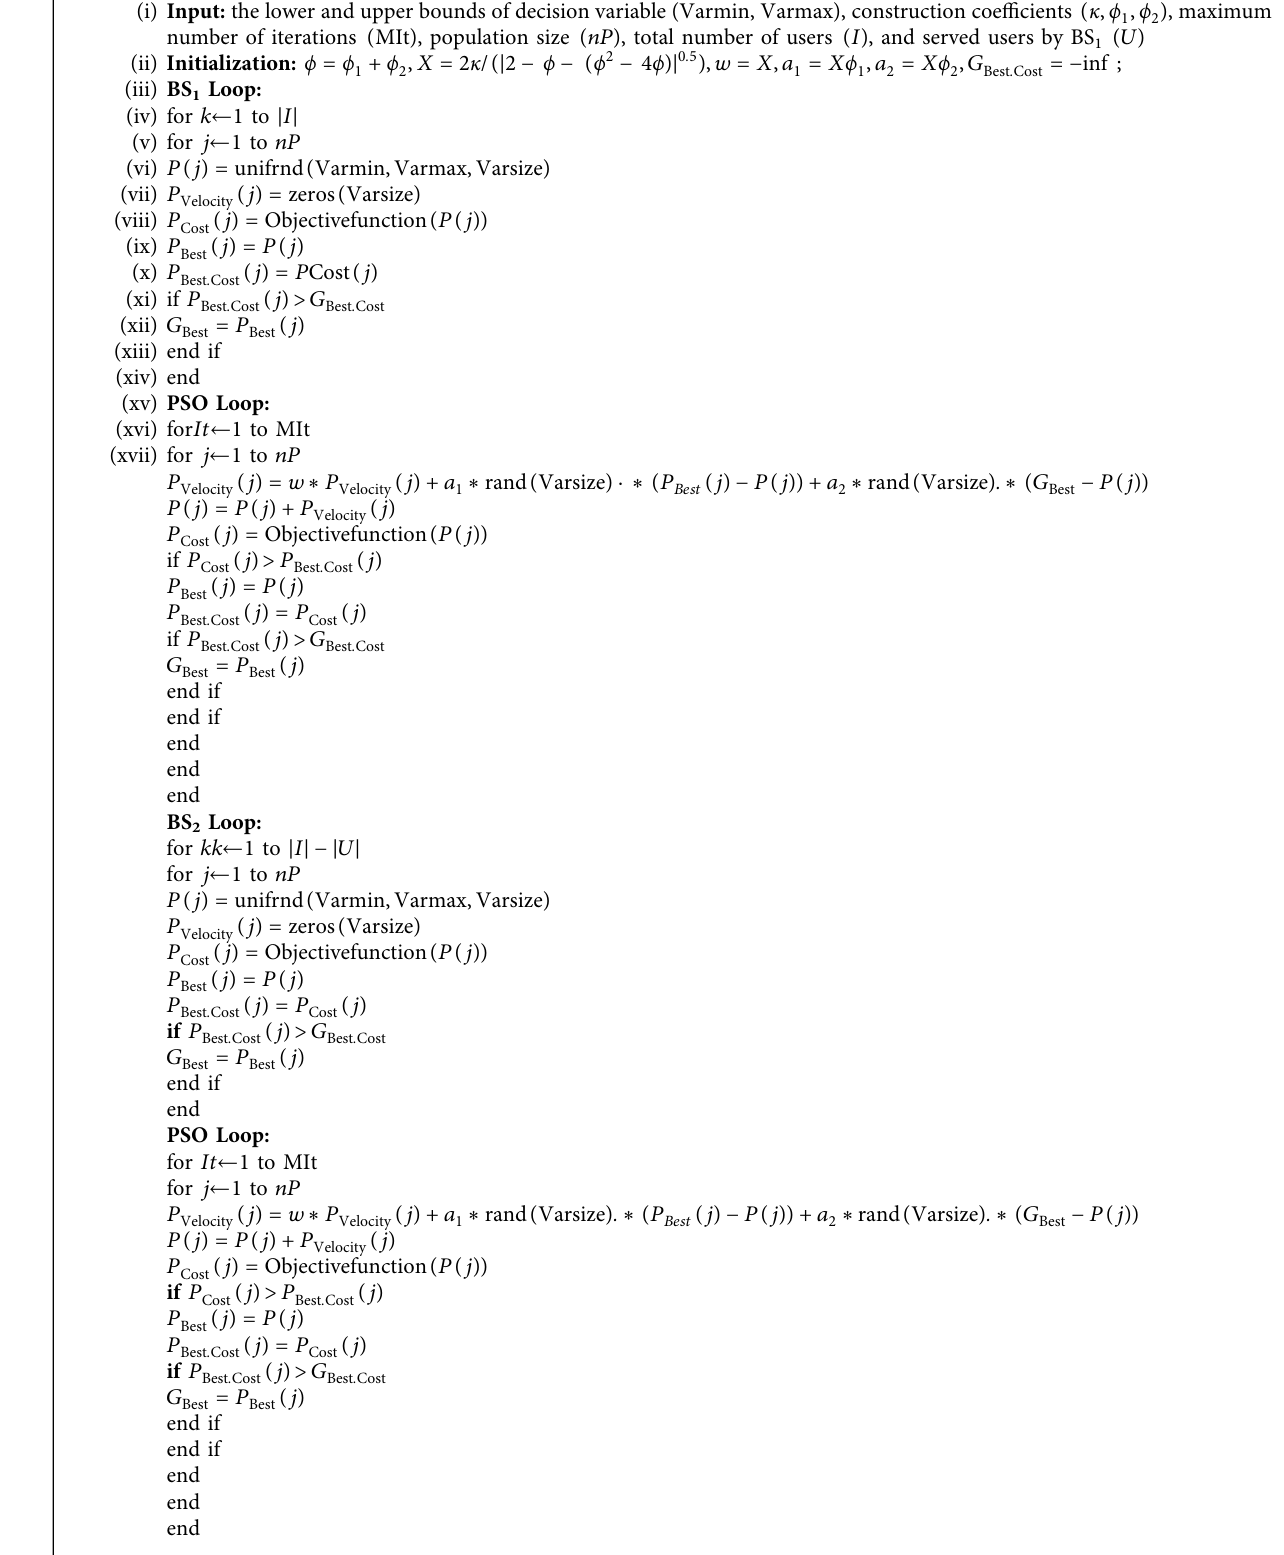
A LGORITHM 1: PSO algorithm that finds the efficient UAVBS